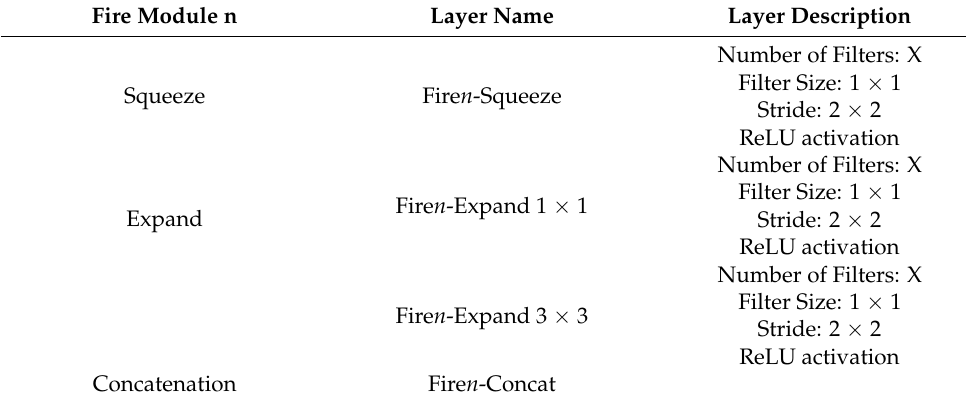
Table 1. Details about the layers in the SqueezeNet-based CNN used in this